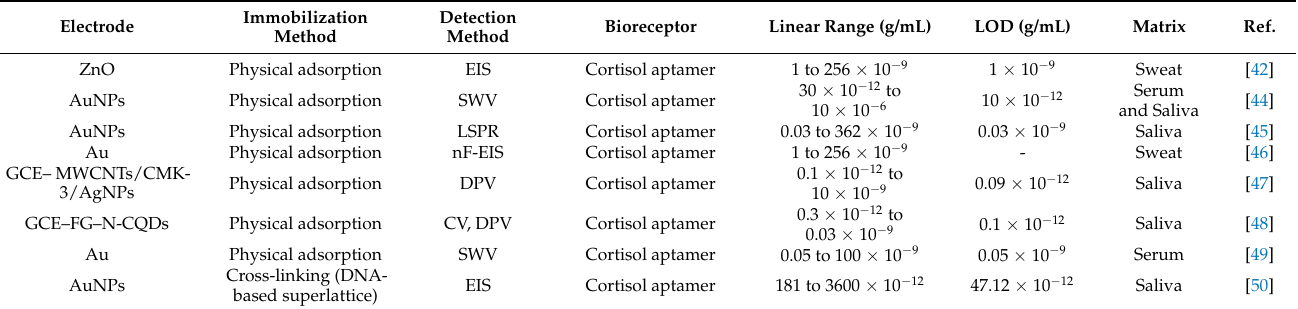
Table 2. Summary of electrochemical immunosensors functioning via cortisol aptamer immobilization.